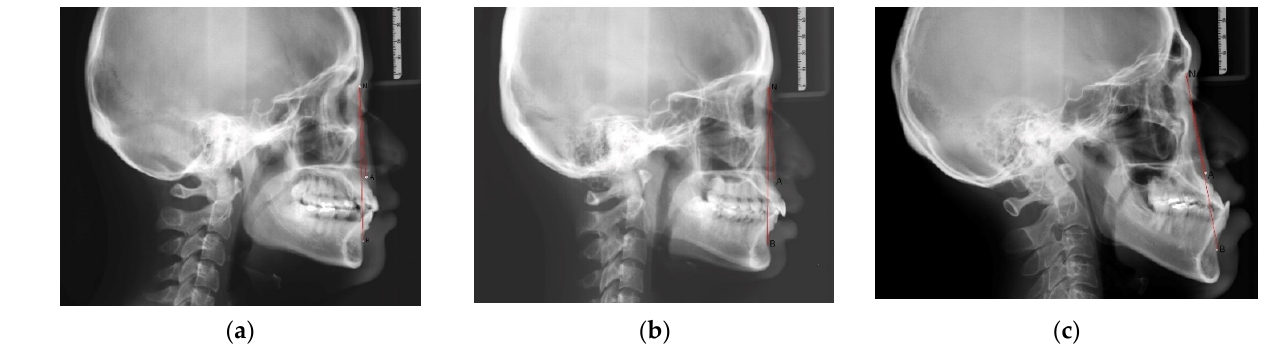
Figure 2. The sagittal skeletal relationship was classified as Class I, Class II, or Class III based on the ANB angle, which was formed by the A point, Nasion, and B point: ( a ) Class I relationship: ANB angle was 2–4 degrees; ( b ) Class II relationship: ANB angle was larger than 4 degrees; ( c ) Class III relationship: ANB angle was smaller than 2 degrees. Table 1. Definitions of terms used in assessing the sagittal skeletal